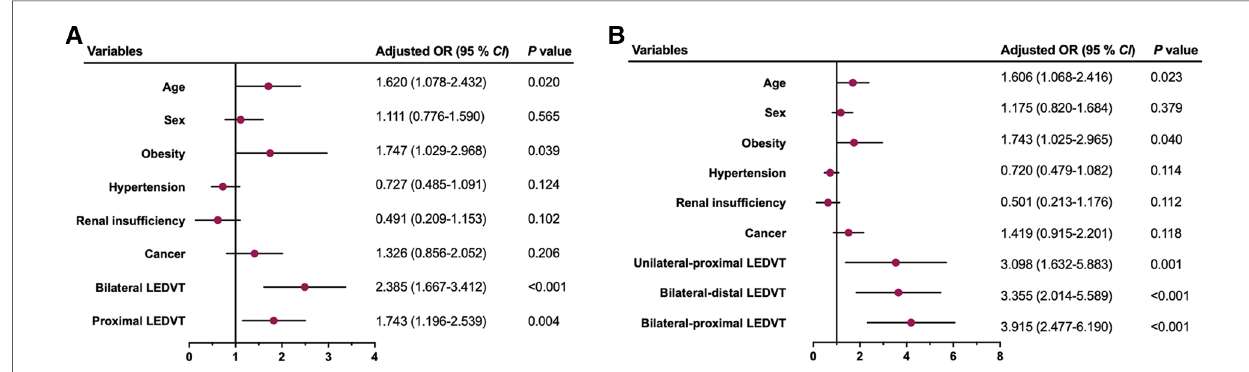
FIGURE 2 Multivariate sensitivity analysis by excluding patients with missing data for the risk of pulmonary embolism. ( A ) Model 1. ( B ) Model 2. OR, odds ratio; CI, con fi dence interval; LEDVT, lower extremity deep venous